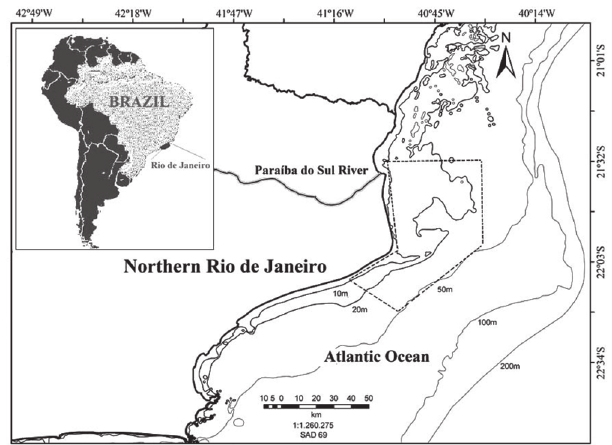
Fig. 1. Northern Rio de Janeiro, in south-eastern Brazil. The sampling area where the Trichiurus lepturus specimens were collected is marked with a dashed